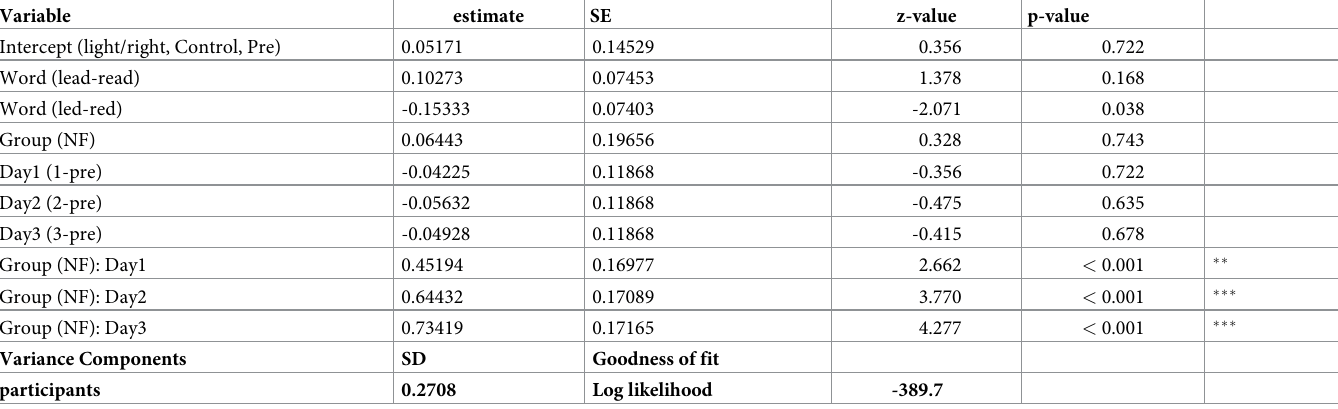
Table 2. Proportion of correct responses in the recognition